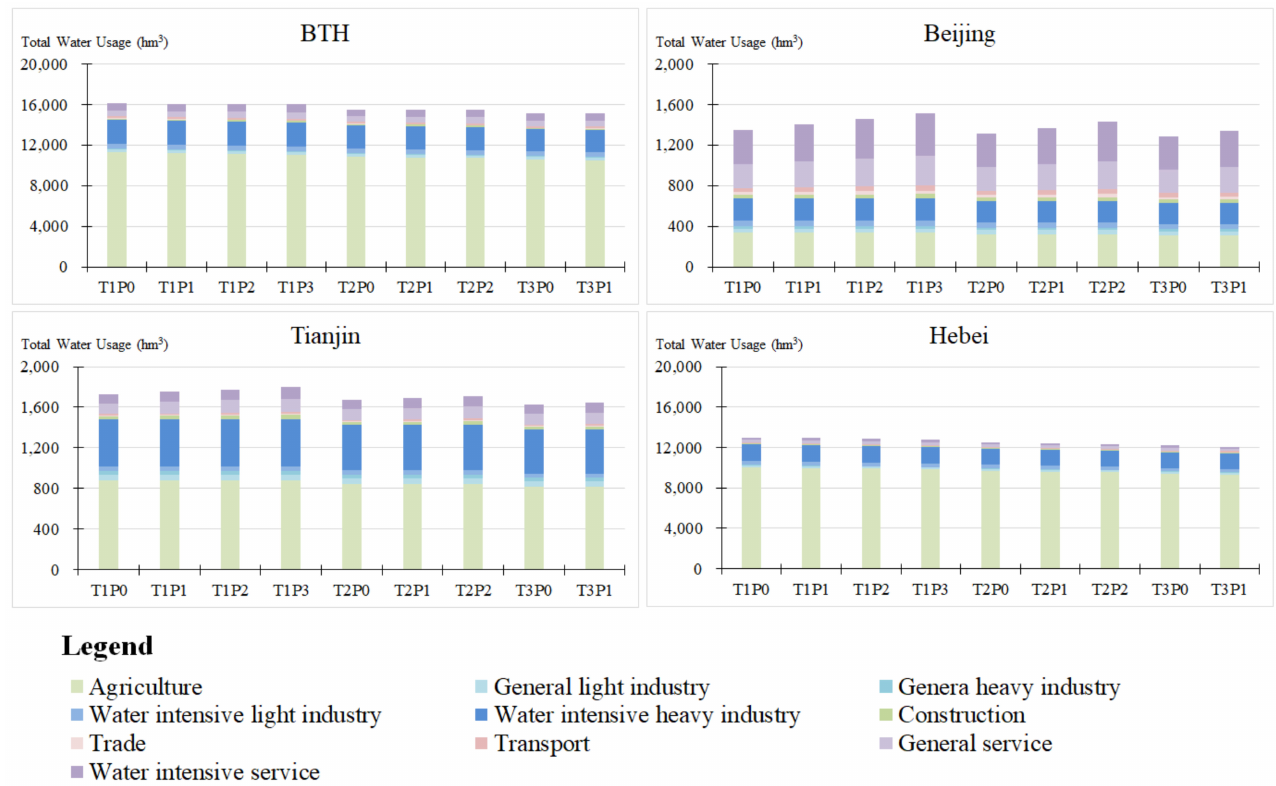
Figure 3. Total water usage in different